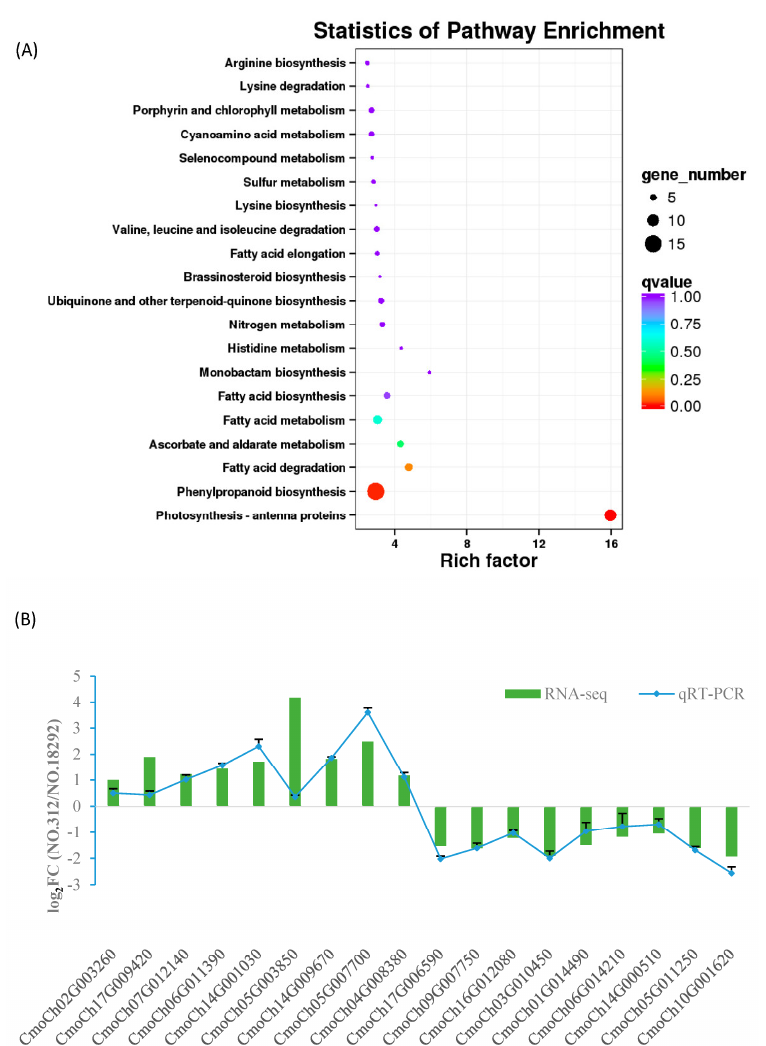
Figure 2. The pathways analysis and the validation of RNA-seq data. ( A ) KEGG pathway enrichment for differentially expressed genes; ( B ) the validation of RNA-seq data using qRT-PCR in the selected DEGs. Relative expression ratio of each DEG is presented in a log 2 Fold Change (No. 312 with ‘taro-like’ aroma vs. No. 18292 without ‘taro-like’ aroma). The values are mean ± SD and error bars represent standard deviations from three independent replicates.